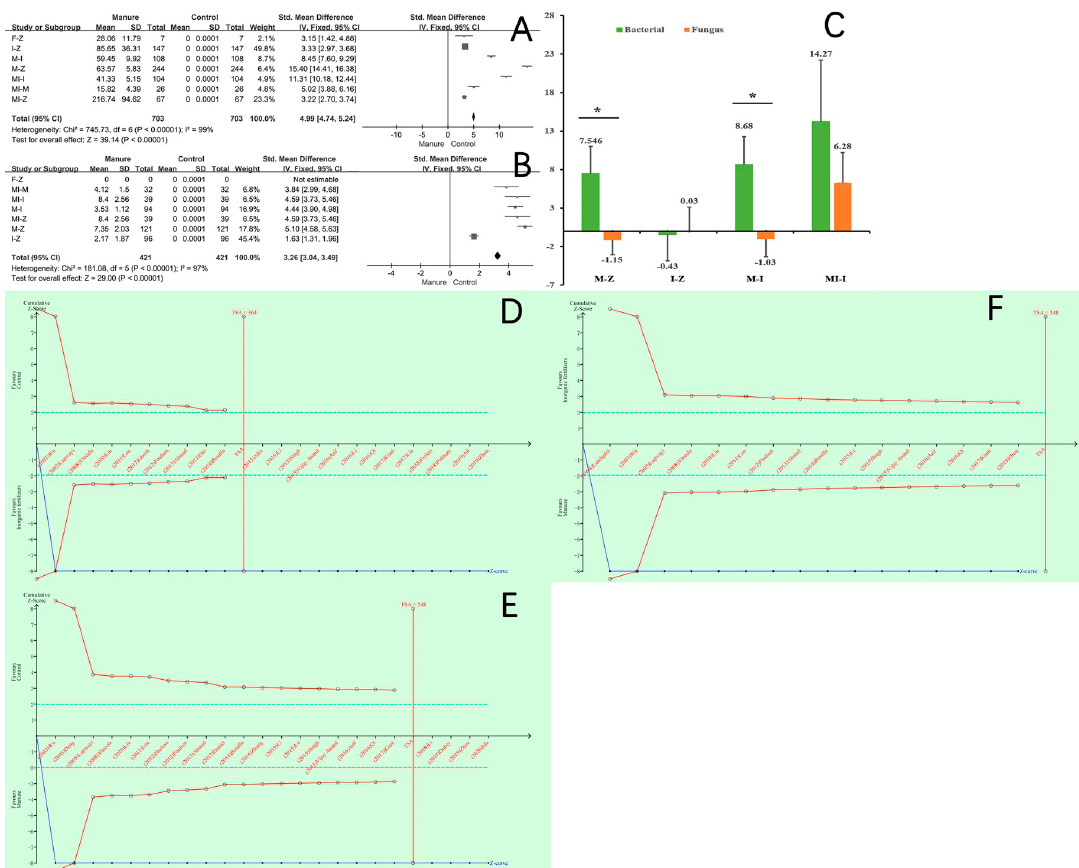
Fig 2. Forest plot of the effects of manure on microbial biomass carbon (MBC) (A) and the Shannon index (B). Confidence interval (CI) = 95%. Mann–Whitney U test of the Shannon index (C). � indicates a significant difference ( p < 0.05). Trial sequential analysis (TSA) of the effects of manure on I-Z (D), M-Z (E), and M-I